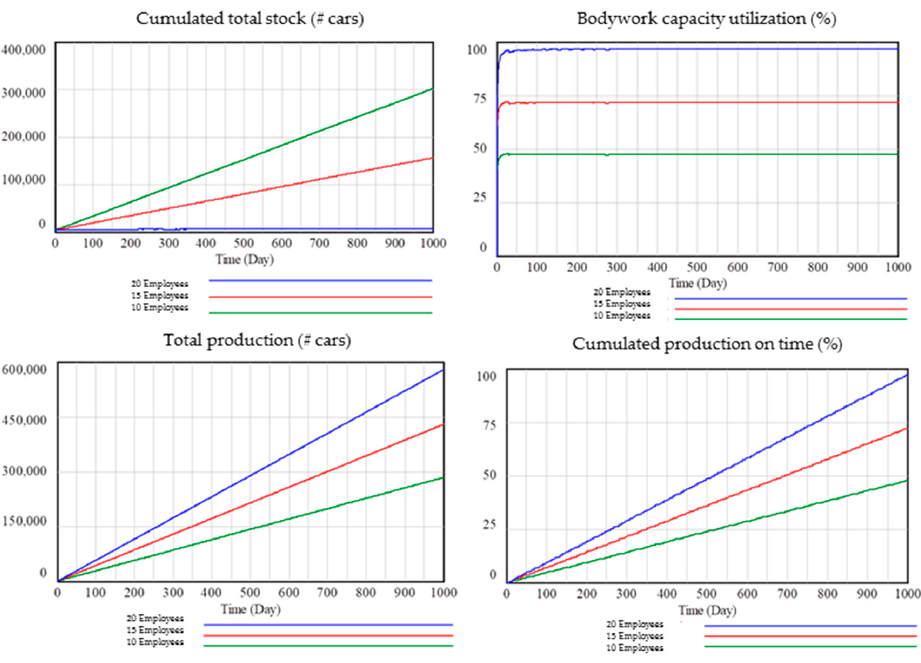
Figure 11. Validation with extreme values: number of employees.